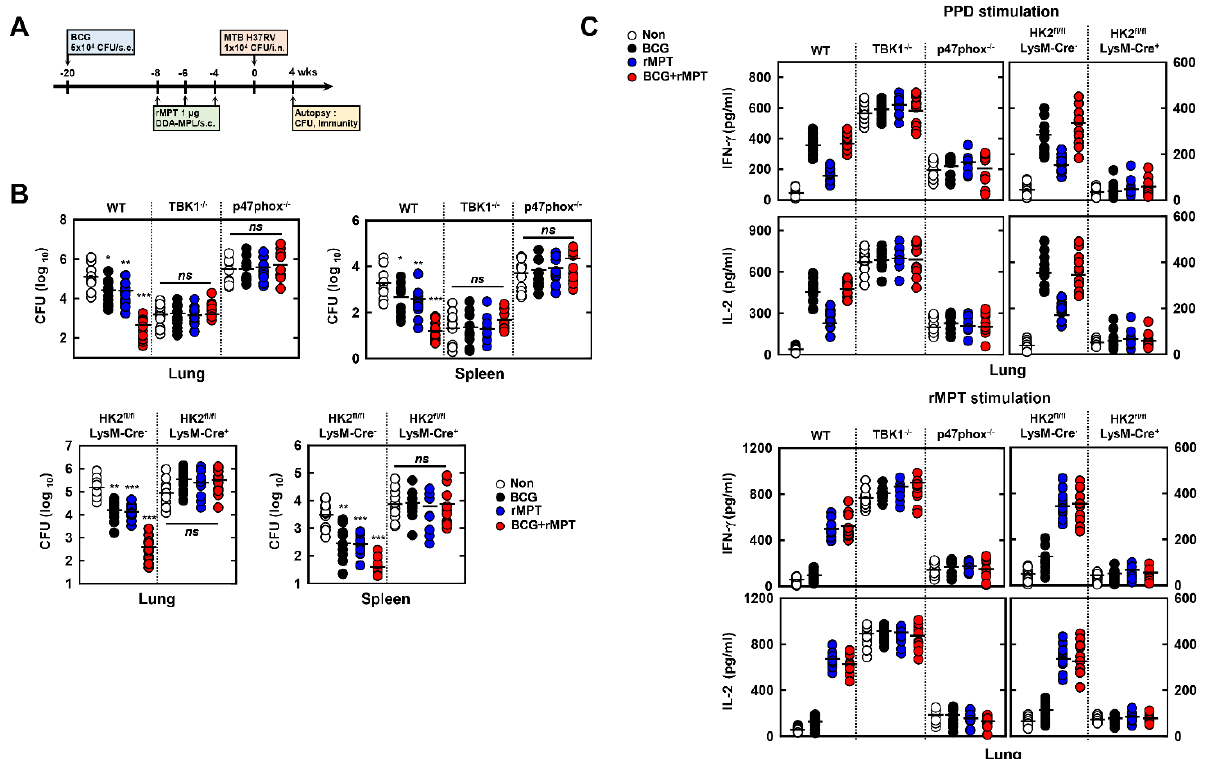
Figure 7. rMPT increases the vaccination against MTB in mice. ( A ) Schematic of the vaccine testing model treated with rMPT in mice. Mice ( n = 10 per group) were immunized by BCG through subcutaneous injection 12 wks before vaccinating with rMPT (1 µ g). Three subcutaneous injection of rMPT with DDA-MPL (adjuvant) were administered before MTB H37Rv intranasal infection. Immunological analysis was carried out after 4 wks. ( B ) CFU in the lungs and spleen in all groups at 4 wks post-infection. ( C ) Mice of each group were sacrificed 4 weeks post-infection, followed by obtaining the lung harvests and stimulating with purified proteins derivative (PPD, 10 µ g/mL) or rMPT (0.1 µ g/mL) in each group. The supernatants were used for measuring the level of IFN- γ and IL-2 by ELISA. The data are representative of four independent experiments with similar results ( B , C ). Significant differences (* p < 0.05, ** p < 0.01; *** p < 0.001) compared with non-treated mice.